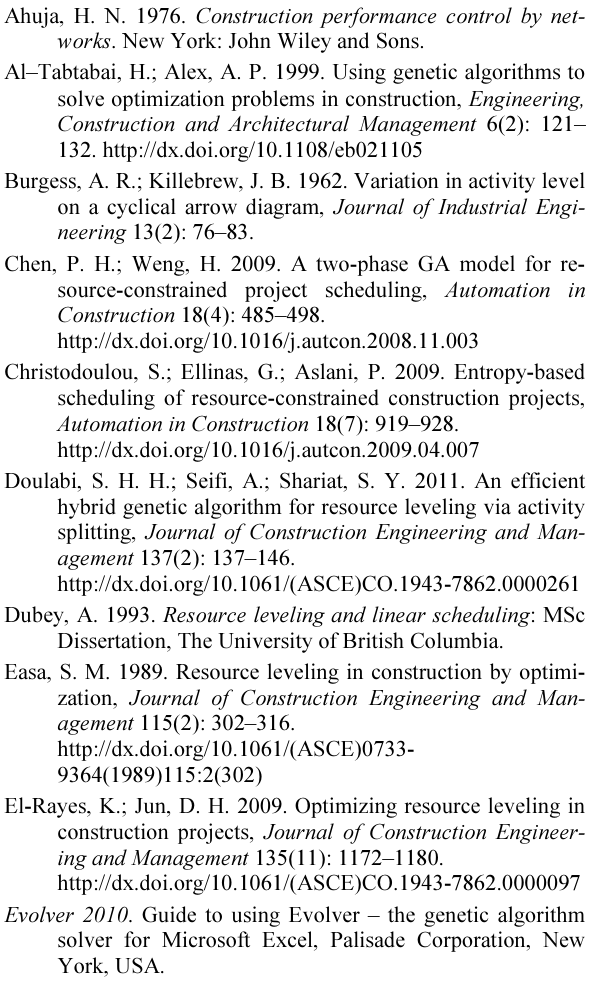
average improvement percentage in different